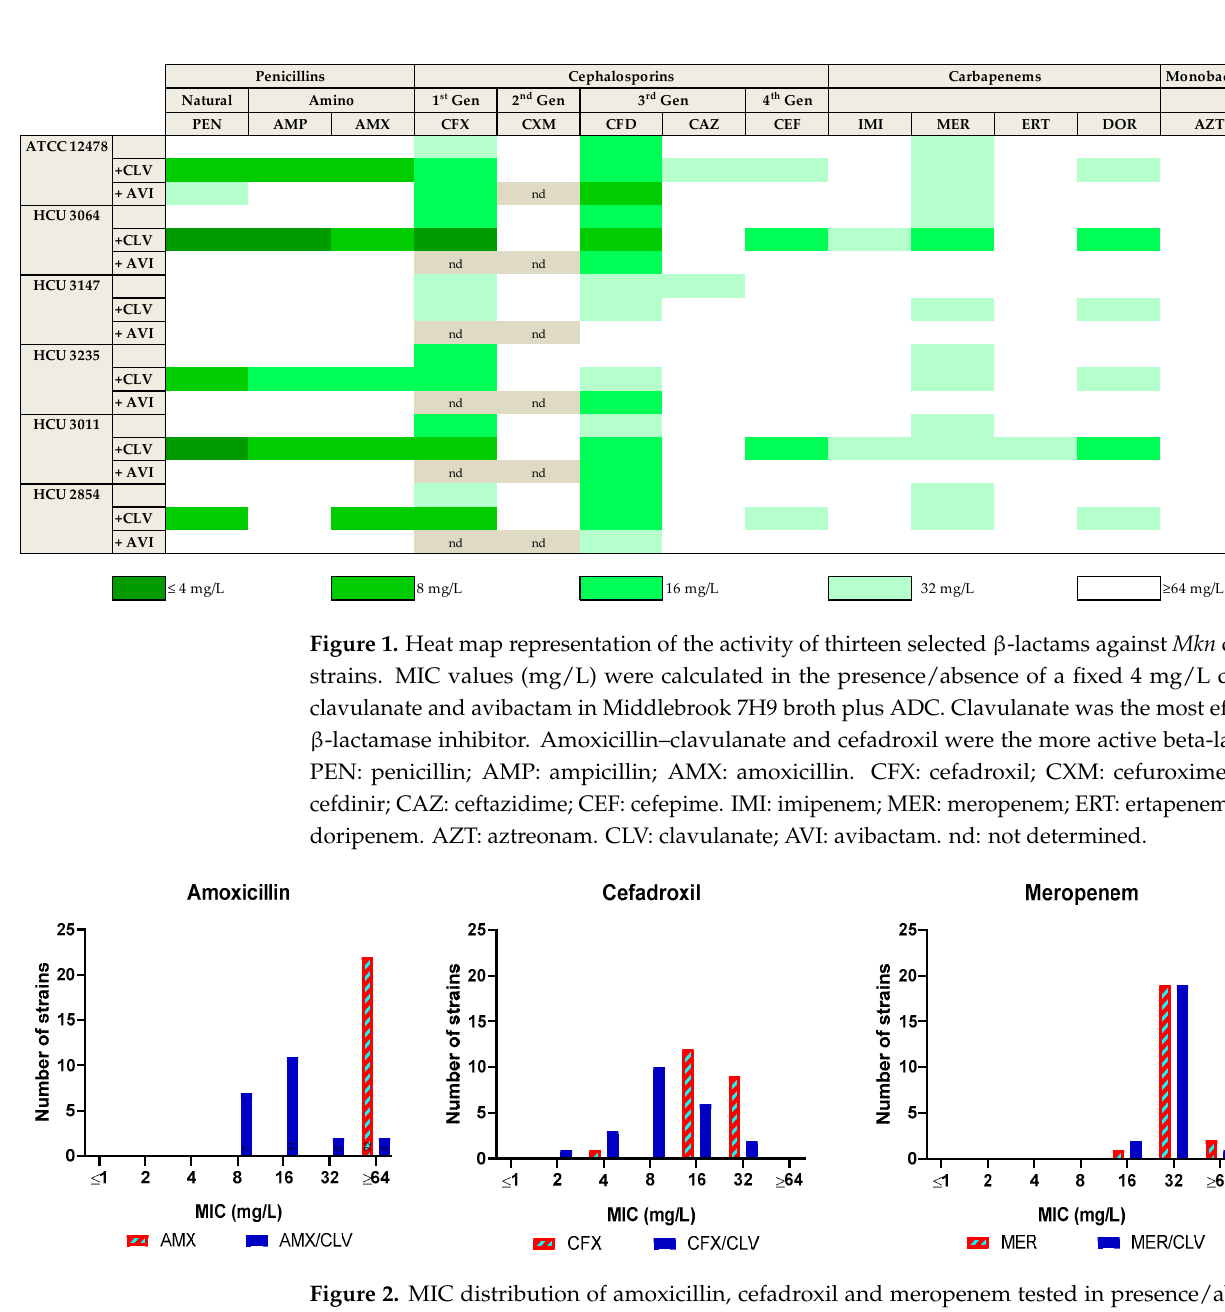
Figure 2. MIC distribution of amoxicillin, cefadroxil and meropenem tested in presence/absence of clavulanate against a panel of Mkn clinical isolates. MIC (mg/L) values were determined in Middlebrook 7H9 broth plus ADC. Clavulanate was added at a fixed 4 mg/L dose. AMX: amoxicillin; CFX: cefadroxil; MER: meropenem; CLV: